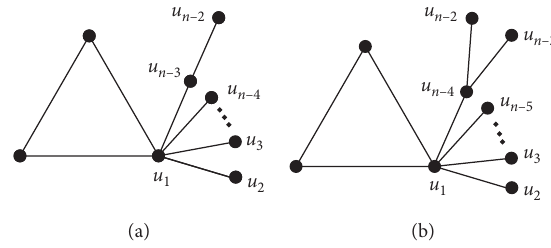
Figure 1: Unicyclic graphs C